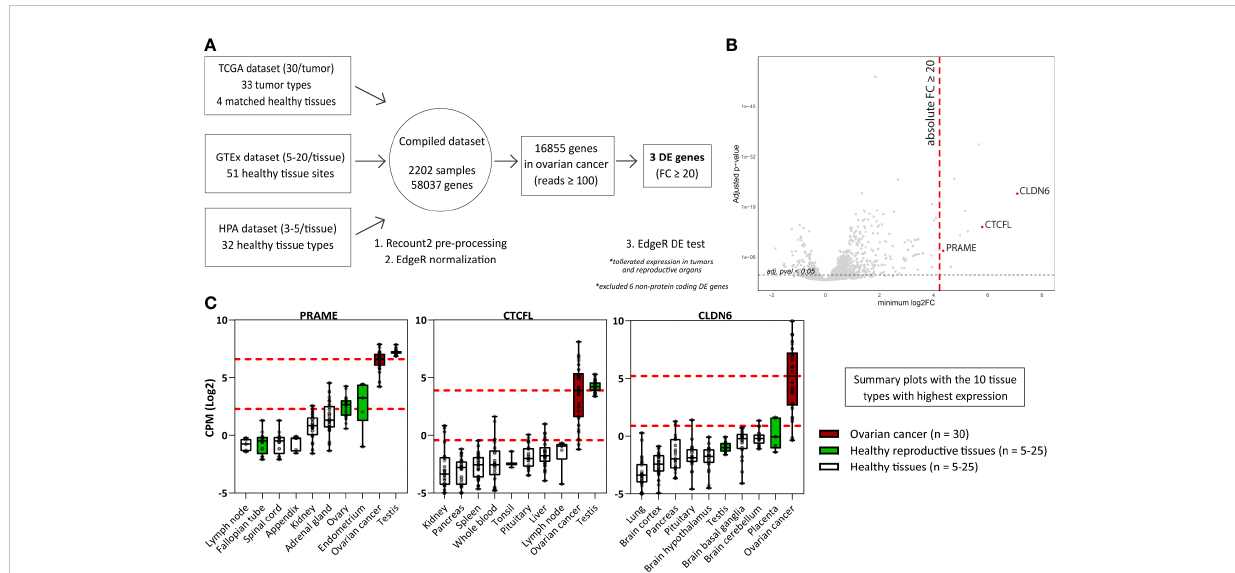
FIGURE 1 Differential gene expression analysis reveals genes associated with High-Grade Serous Ovarian Carcinoma. (A) Scheme depicting the differential gene expression analysis strategy. (B) Plot displaying for all genes the minimum FC against the adj. p-val. Indicated in red are the three identi fi ed DE genes (FC ≥ 20; adj. p-val ≤ 0.05). Indicated in grey are non-DE genes and non-protein coding genes. (C) Boxplots depicting PRAME , CTCFL and CLDN6 expression in ovarian cancer (TCGA data, n = 30) and the 9 healthy tissue types with highest gene expression (HPA and/or GTEx data, n = 5- 25). Overlapping healthy tissue types within the HPA and GTEx were combined when possible. Boxplots extend from fi rst to third quartile, the horizontal line represent the median expression value. The whiskers represent minimum and maximum expression. The upper and lower red dashed lines represent the median expression value and the 20 times lower expression value, respectively. (Adj. p-val: false discovery rate adjusted p-value, DE, differentially expressed; FC, fold change; GTEx, genotype-tissue expression; HPA, human protein atlas; CPM Log2, log2-transformed counts per million; minimum log2FC, log2 fold change; TCGA, The cancer genome